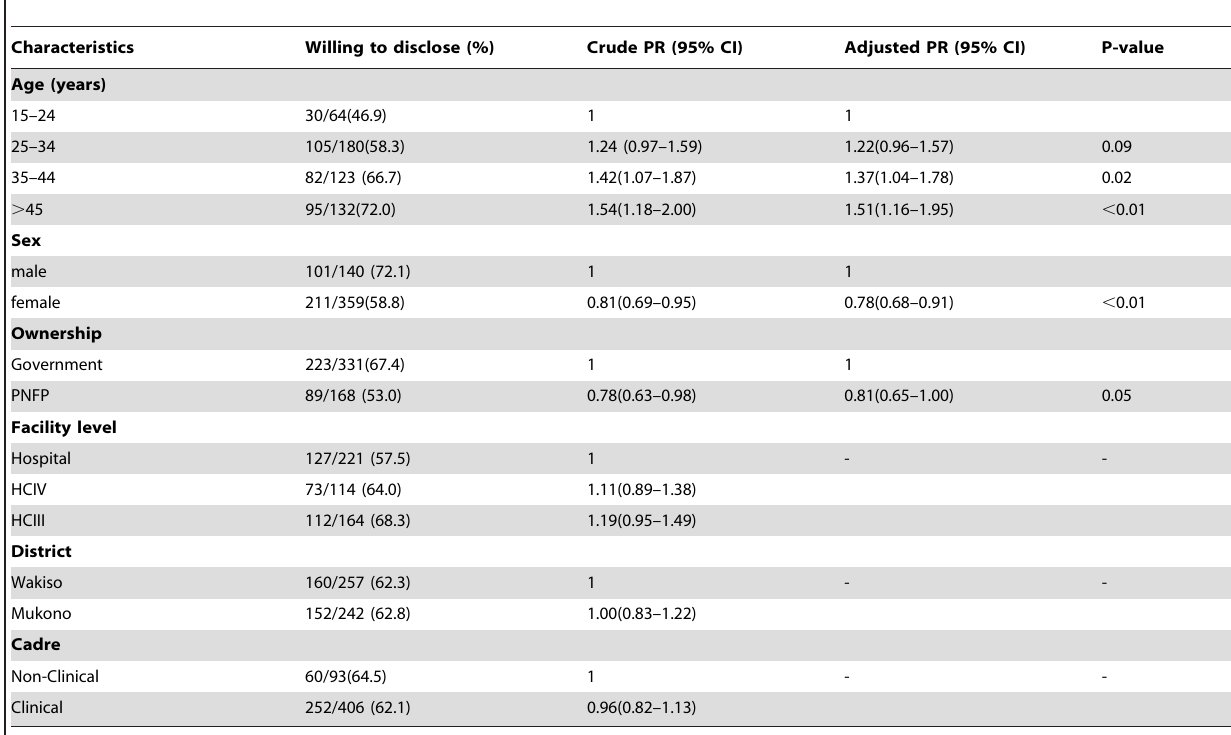
Table 3. Bivariate and multivariable analysis of willingness to disclose an HIV positive status to a supervisor/manager among health care workers in Wakiso and Mukono in